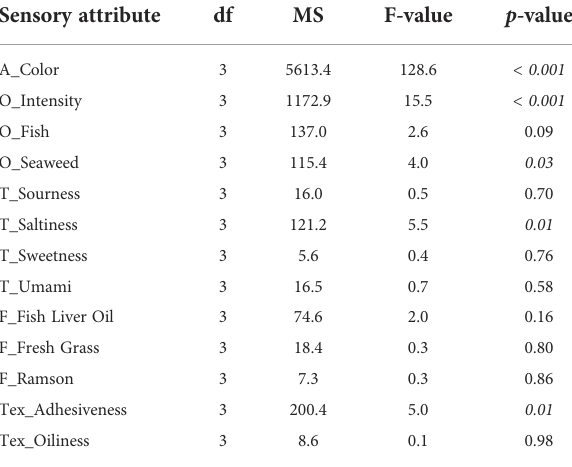
TABLE 7 Two-way ANOVA of the sensory attributes for Ulva fenestrata cultivated under two different herring production process waters (SAL and TUB), as well as a seawater control